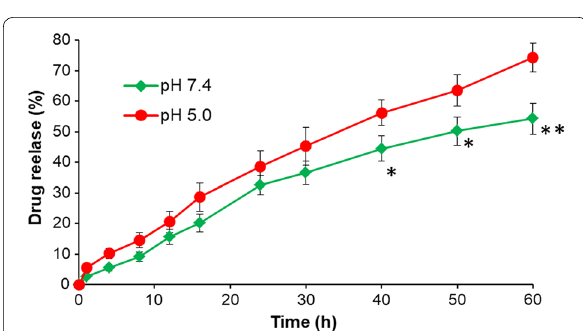
Fig. 3 In vitro drug release study of CD/LP‑miCDDP in pH 7.4 and pH 5.0 conditions. *p < 0.05, *p < 0.01 pH 7.4 vs pH